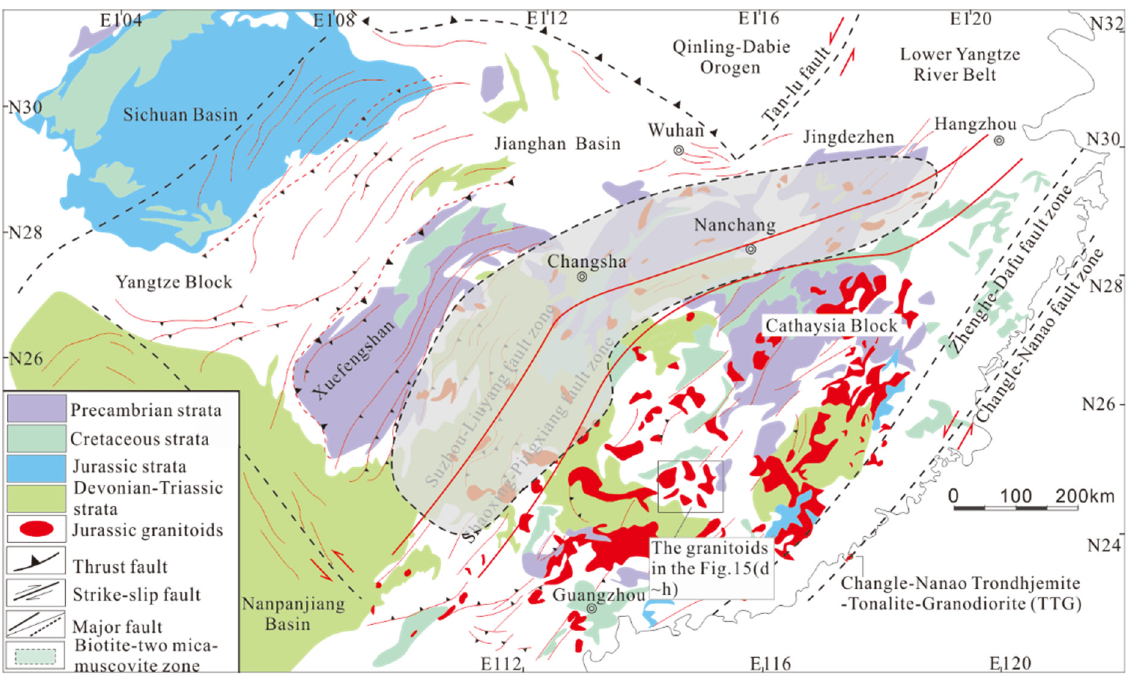
Figure 13. Simplified geological map of South China delineating the distributions of the Jurassic magmatic rocks, biotite–two-mica–muscovite zone and Changle–Nanao Trondhjemite–Tonalite– Granodiorite (TTG) (modified from [109,111,122–125].